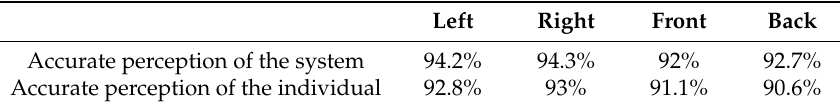
Table 1. Success rate of our system real time and obtained after computer.